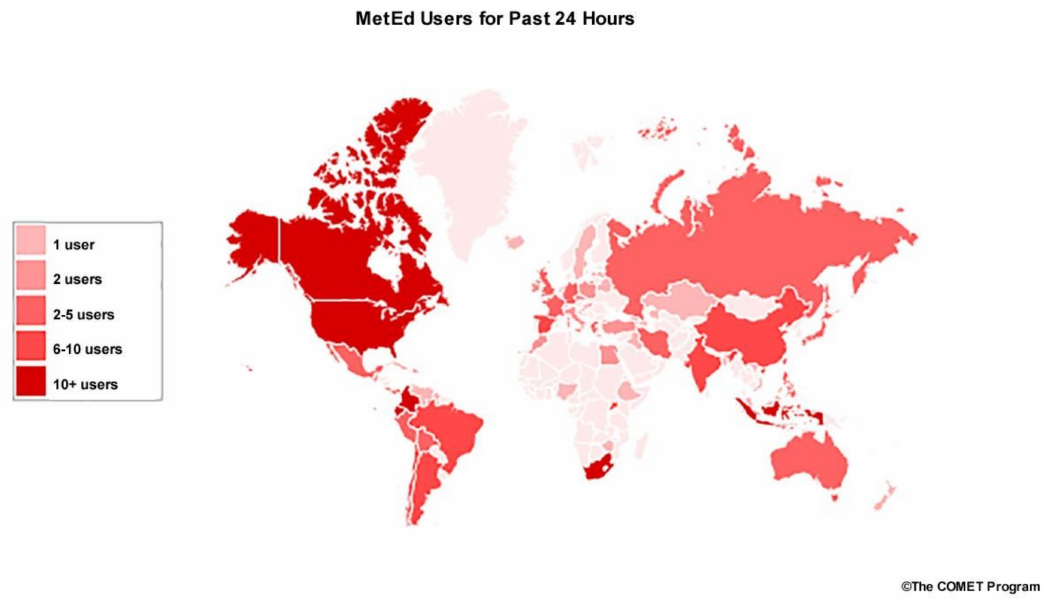
Figure 1. Map showing daily access to MetEd by country. MetEd serves over 190 countries and territories worldwide, with approximately 600,000 registered users as of April